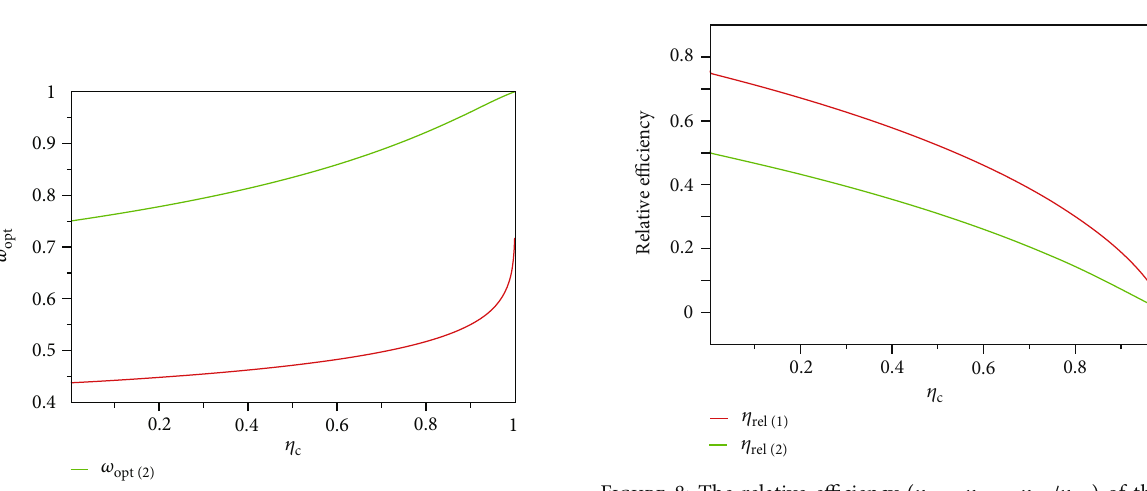
Figure 8: The relative e ffi ciency ( η cases of optimization criteria versus Carnot e ffi